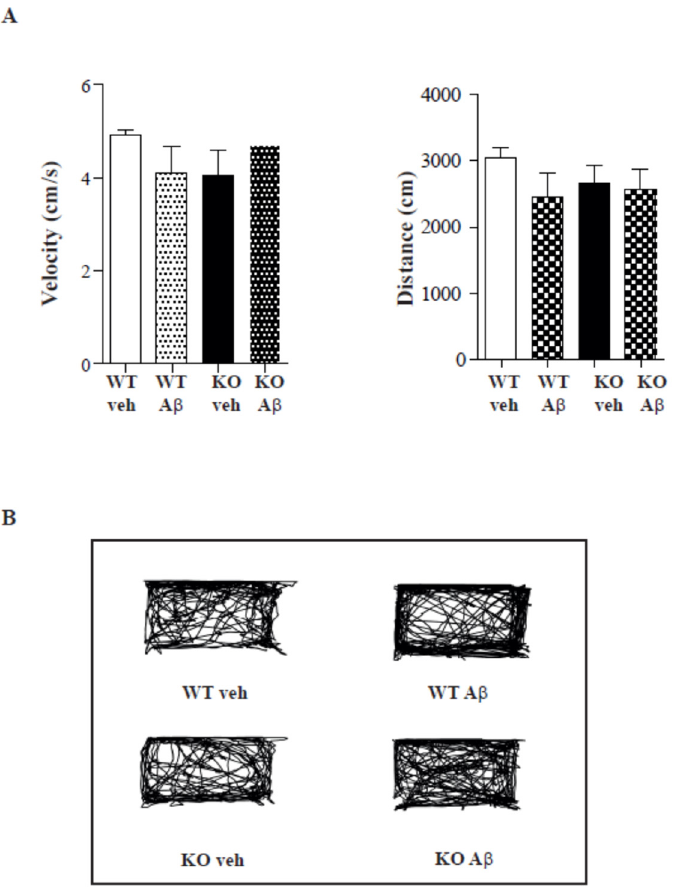
Figure 6. ( A ) Open field velocity and distance for TAAR1 and control animals treated or not with A β . ( B ) Trace examples of thigmotaxis analysis in a square open field. Neither control nor TAAR1 mice showed anxiety, regardless of the treatment received (A β or vehicle).